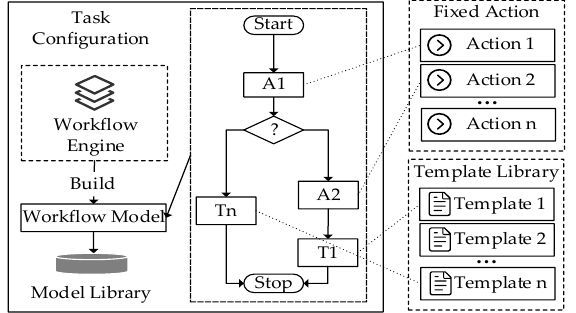
Figure 5. Task configuration.